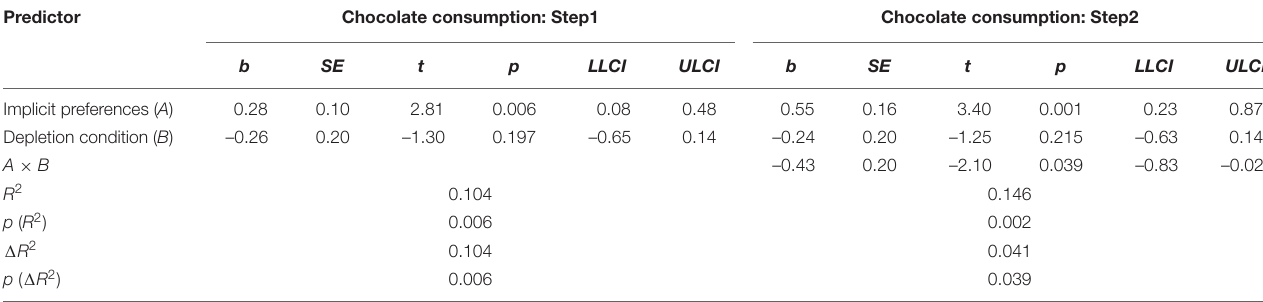
TABLE 2 | Summary of multiple regression analysis for chocolate consumption with implicit preferences and depletion condition as predictors.